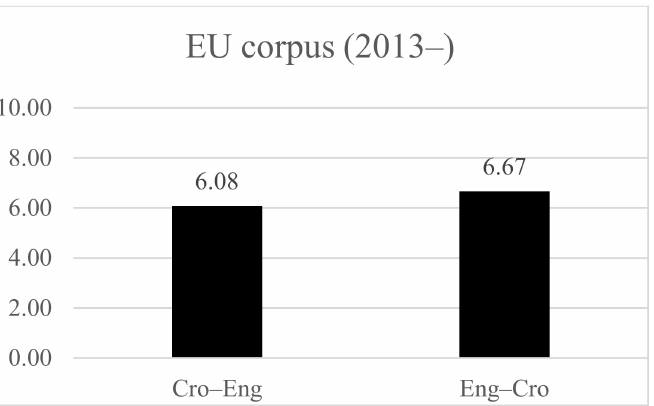
Figure 4. HHI scores for selected high-frequency terminology, showing better scores for English– Croatian language pairs